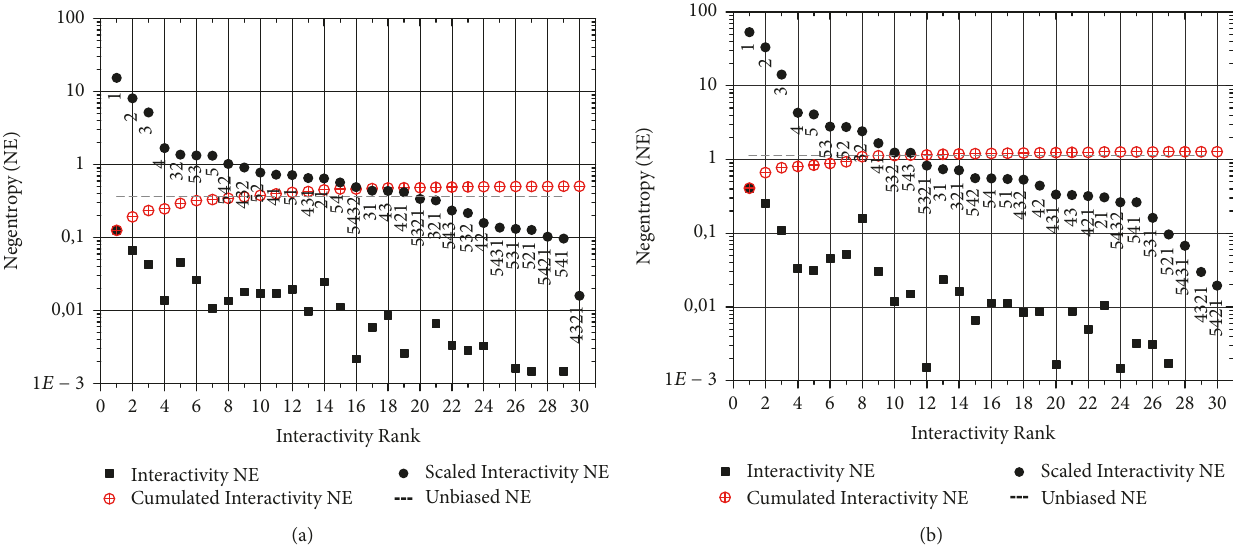
Figure 9: Sorted scaled-interactivities by decreasing order (solid circles), ITIs (solid squares) with cumulated ITIs (open crossed circles) and unbiasedtotalNE(horizontaldashedline).ThesortedICgroupsarelabeled(e.g.,32meansgroupofIC2andIC3).The95%confidencelevelsof the selected ITIs are those for which the cumulated ITIs are below the dashed line. (a) Case (a): high noise and (b) case (b): intermediate noise.